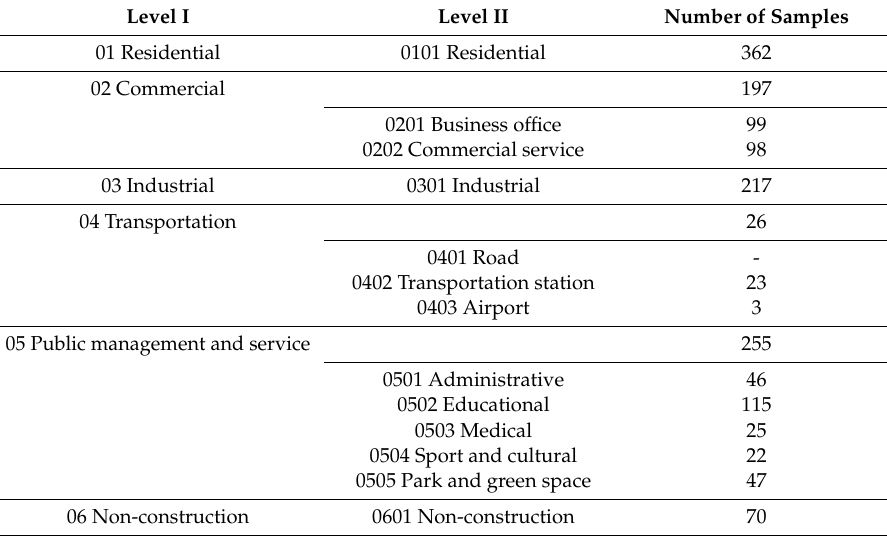
Table 1. Types of land use and sample size.